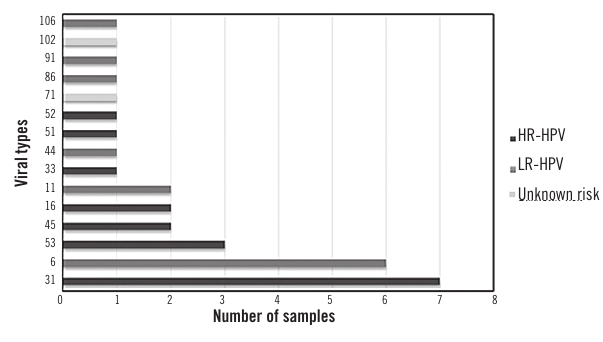
figurE − Distribution of viral types identified by TS-PCR and RFLP in HPV positive self- collected samples from female sex workers TS-PCR: type-specific polymerase chain reaction; RFLP: restriction fragment length polymorphism; HPV: human papillomavirus; HR-HPV: high-risk oncogenic HPV; LR-HPV: low-risk oncogenic